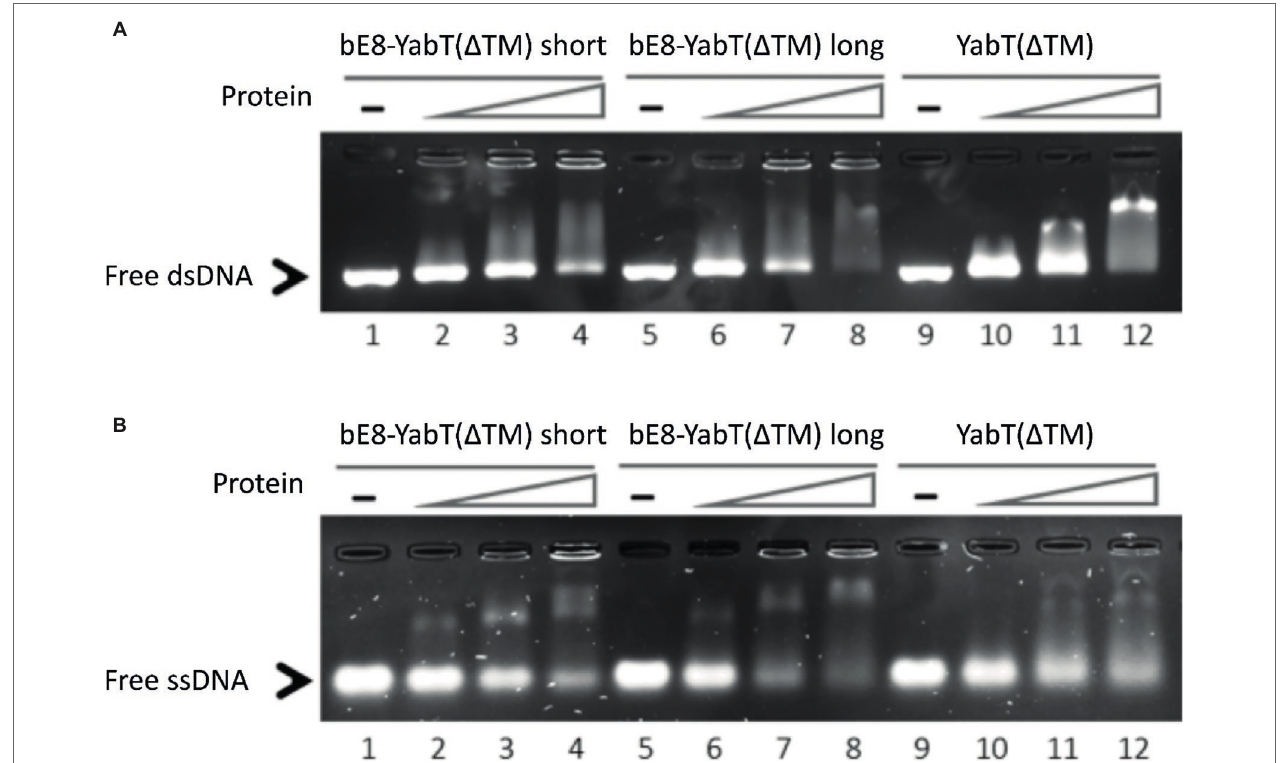
FIGURE 2 | DNA-binding activity of the short and long forms of the bE8-YabT( ∆ TM) fusion protein. 0.075 μ M dsDNA (210 bp) (A) and 0.15 μ M ssDNA (90 nt) (B) were incubated at 310 K for 30 min with 0 μ M (lane 1, 5 and 9), 0.4 μ M (lane 2, 6 and 10), 0.8 μ M (lane 3, 7 and 11), and 1.2 μ M (lane 4, 8 and 12) of protein, respectively. The samples were then submitted to electrophoretic mobility shift assays (EMSA). The activity of YabT( ∆ TM) is used as positive